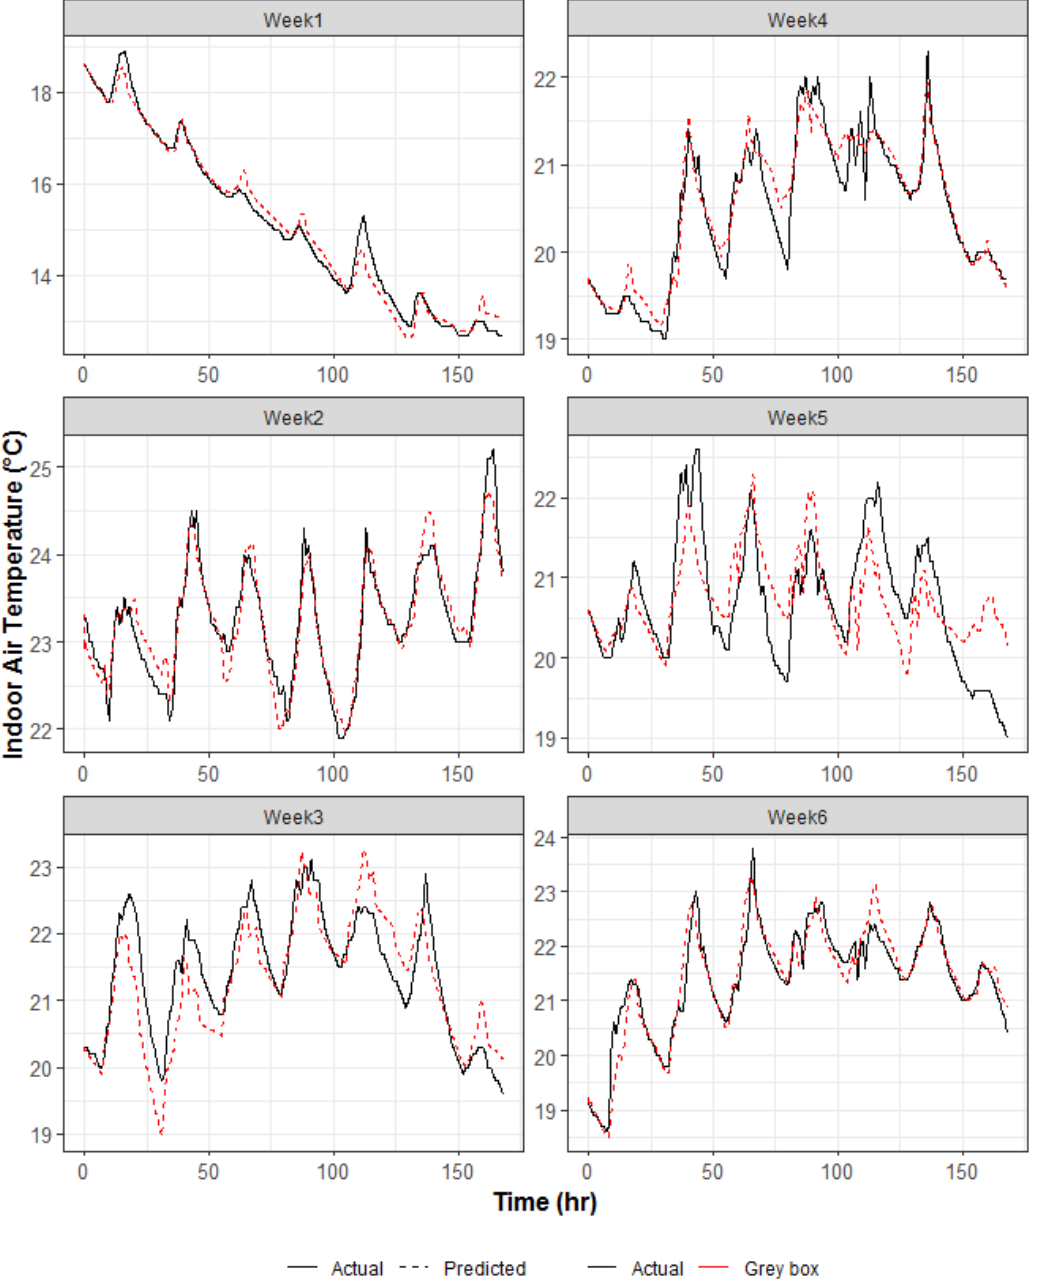
Figure 5. Line graphs of GB model performance showing empirical and predicted air temperatures using C1V5 calibration approach for calibration weeks only.